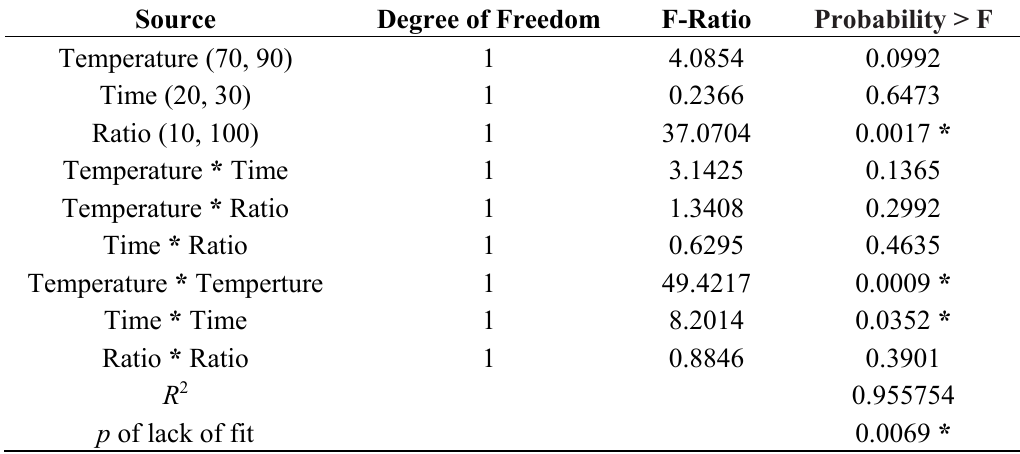
Table 2. Analysis of variance for determination of model